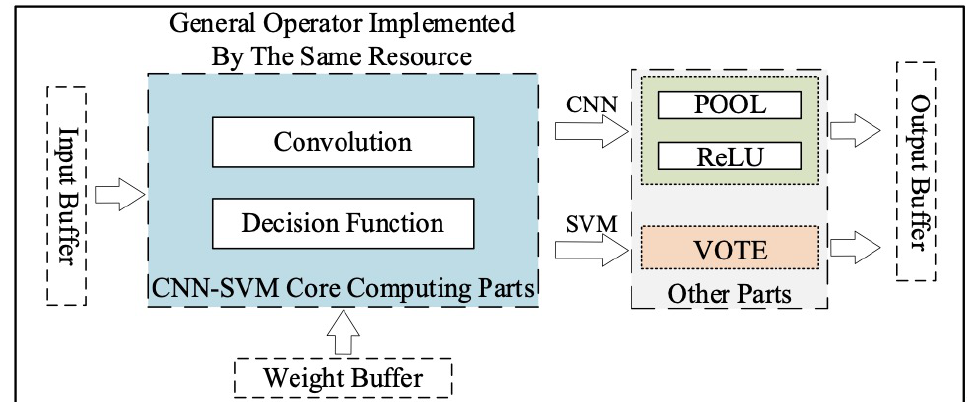
Figure 1. Overall architecture of the hybrid CNN-SVM accelerator.